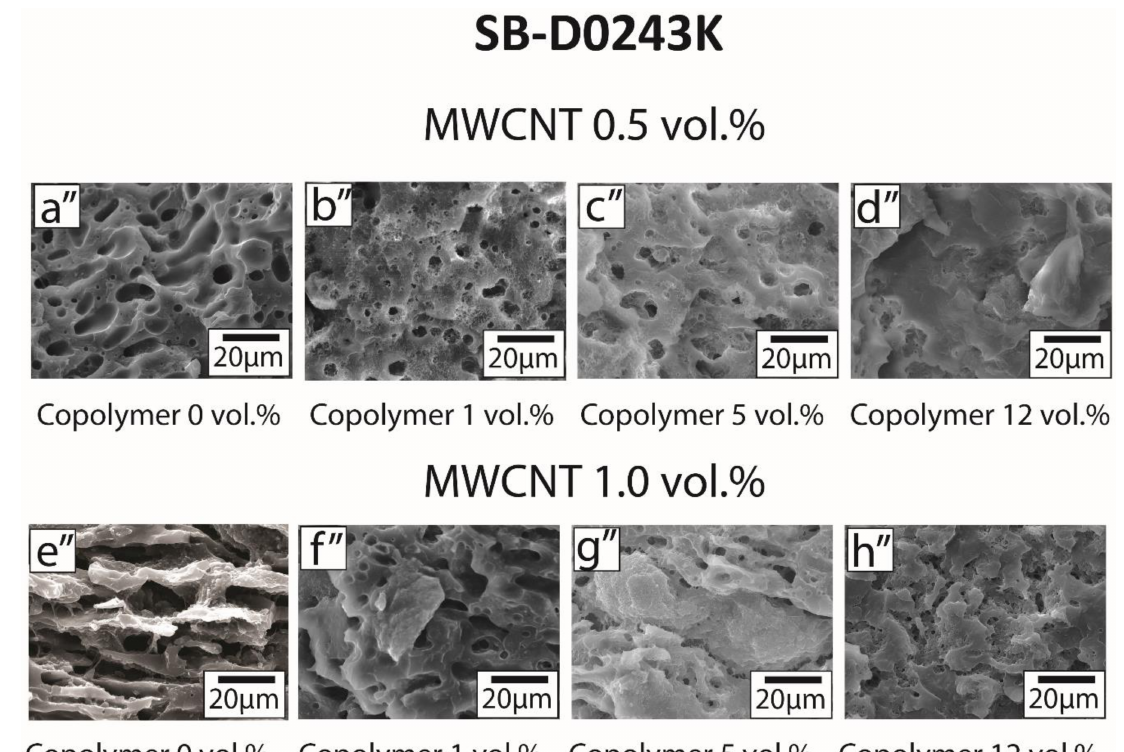
Figure 6. SEM micrographs of ( a – d ) PP:PS/70:30/SB-D1431P/MWCNT 0.5 vol.% and ( e – h ) PP:PS/70:30/SB-D1431P/ MWCNT 1.0 vol.%. ( a’ – d’ ) PP:PS/70:30/SBS-D1102K/MWCNT 0.5 vol.% and ( e’ – h’ ) PP:PS/70:30/SBS-D1102K/MWCNT 1.0 vol.%. ( a” – d” ) PP:PS/70:30/SB-D0243K/MWCNT 0.5 vol.% and ( e” – h” ) PP:PS/70:30/SB-D0243K/MWCNT 1.0